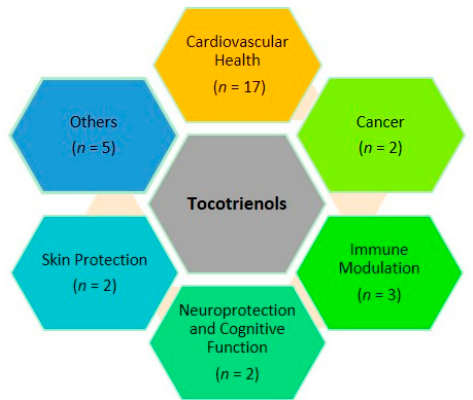
Figure 1. Therapeutic effect of tocotrienols studied/observed in clinical settings.